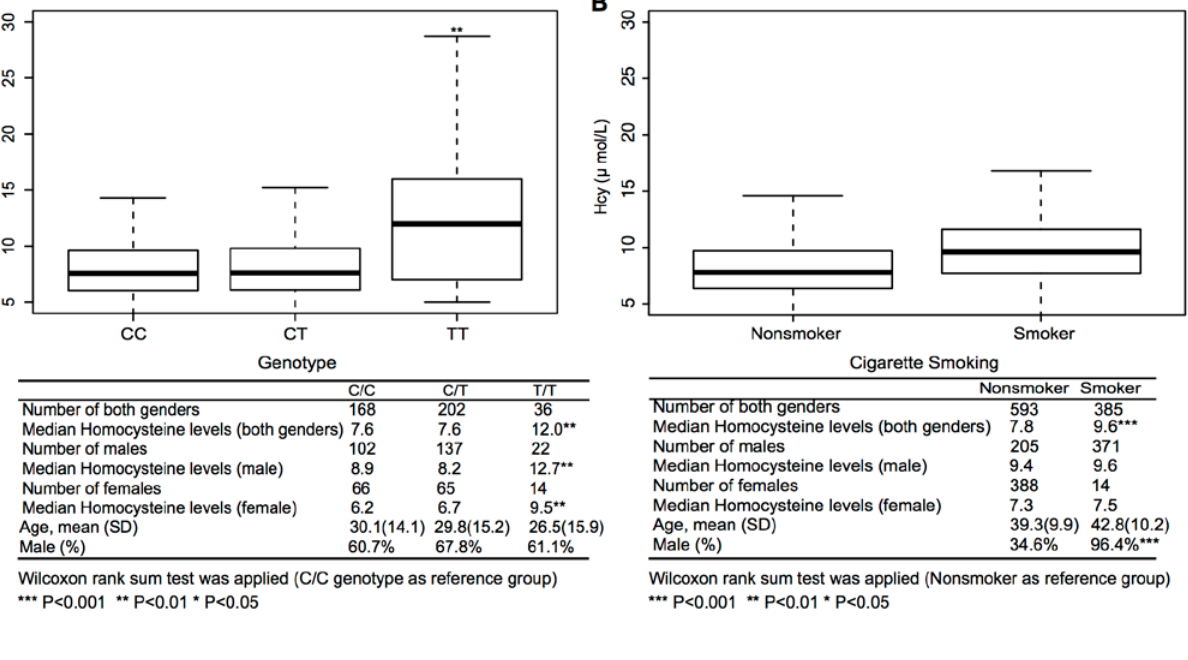
Figure 3. Homocysteine levels by MTHFR genotypes ( A ) and cigarette smoking profiles ( B